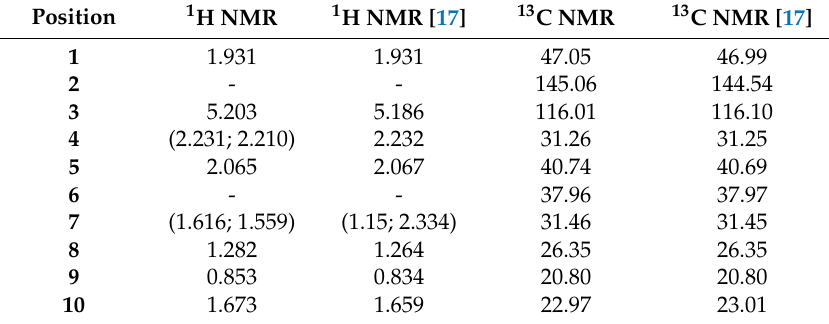
Table 2. NMR data of the α -pinene substance (S 1) compared to literature data.